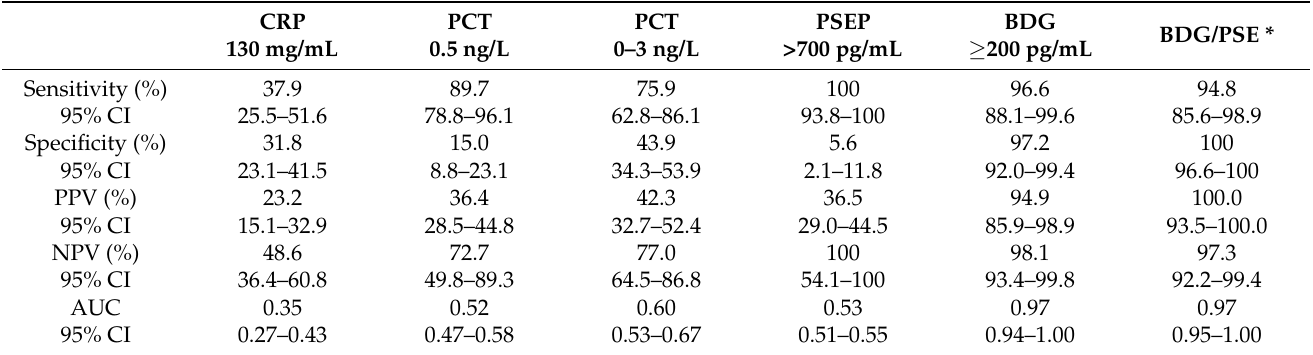
Table 3. Biomarker cut-offs with the highest diagnostic significance for invasive candidiasis.